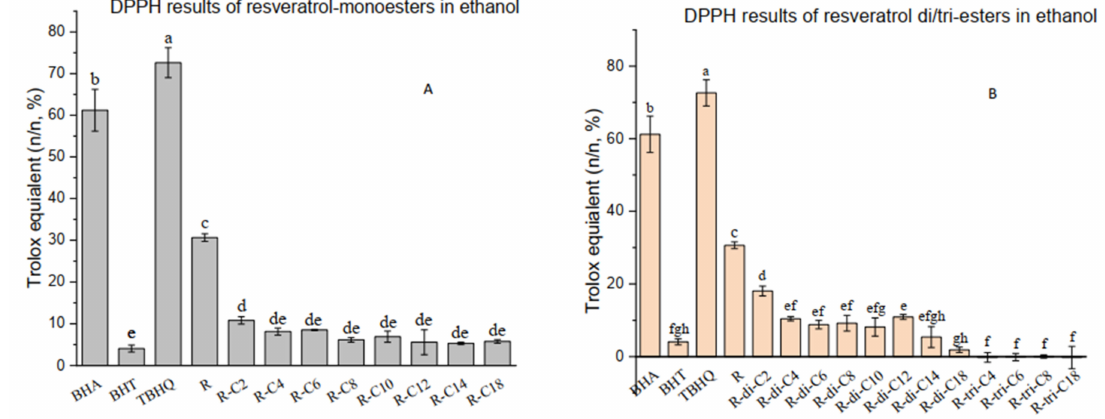
Figure 2. DPPH radical-scavenging capacity. ( A ): DPPH radical scavenging capacity in mole efficacy equivalent of Trolox per mole of resveratrol (R) or its monoesters (%, n/n ). R-C2, R-C4, R-C6, R-C8, R-C10, R-C12, R-C14, R-C18 are resveratrol esters of acetic, butyric, caproic, caprylic, capric, lauric, myristic, and stearic acids, respectively. ( B ): DPPH radical scavenging capacity in mole efficacy equivalent of Trolox per mole of resveratrol (R) or its di-/triesters (%, n/n ). R-di-C2, R-di-C4, R-di-C6, R-di-C8, R-di-C10, R-di-C12, R-di-C14, and R-di-C18 are resveratrol diesters of acetic, butyric, caproic, caprylic, capric, lauric, myristic, and stearic acids, respectively; R-tri-C4, R-tri-C6, R-tri-C8, and R-tri-C18 are resveratrol triesters of caproic, caprylic, capric, and stearic acids, respectively. Each assay was replicated 3 times. Entries with different letters were significantly different at p < 0.05, performed by Tukey’s HSD